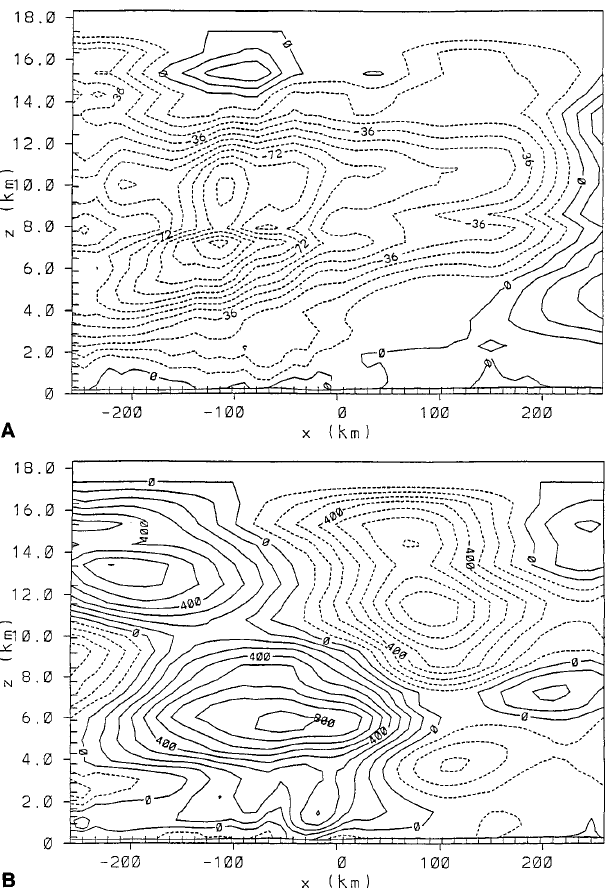
Fig. 14A, B. Vertical velocity in a vertical cross section, for August 19, 1994, at A 1800 UTC and B 600 UTC. Cross section taken at 6 km east of the centre of the domain. Topography outline at the bottom . Dashed lines indicate negative values. Iso lines at